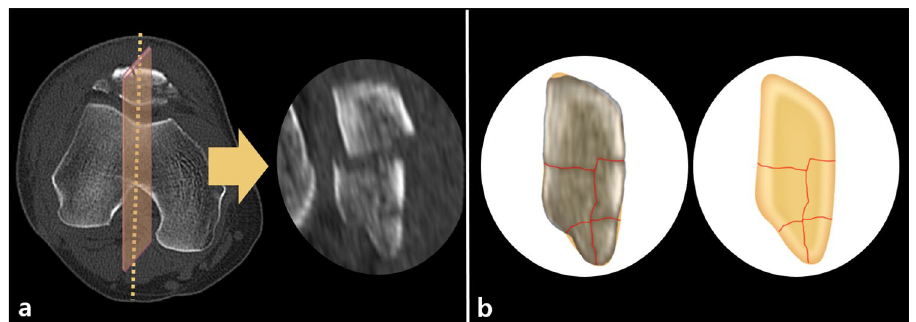
Figure 3. Two-dimensional computed tomography (CT) mapping of the midsagittal fracture pattern. A CT image of the patellar vertical ridge shows displaced and comminuted patellar fractures with coronal fragment and inferior pole fractures ( a ). The fracture fragments were reduced on the basis of a sagittal template. The fracture line (red line) was marked on the template ( b ).